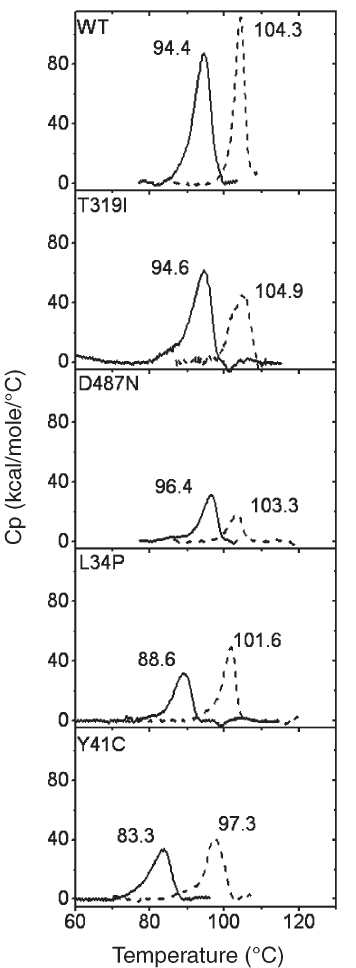
Figure 3. Differential scanning calorimetry thermograms of Sul- folobus solfataricus recombinant WT amidase and its mutants at dif- ferent pH values. Protein concentration expressed as moles of dimer. The buffer was 20 mM citrate at pH 4.0 (dashed lines) and 20 mM so- dium phosphate at pH 8.0 (solid lines). Denaturation temperatures ( T m ) are indicated above the corresponding